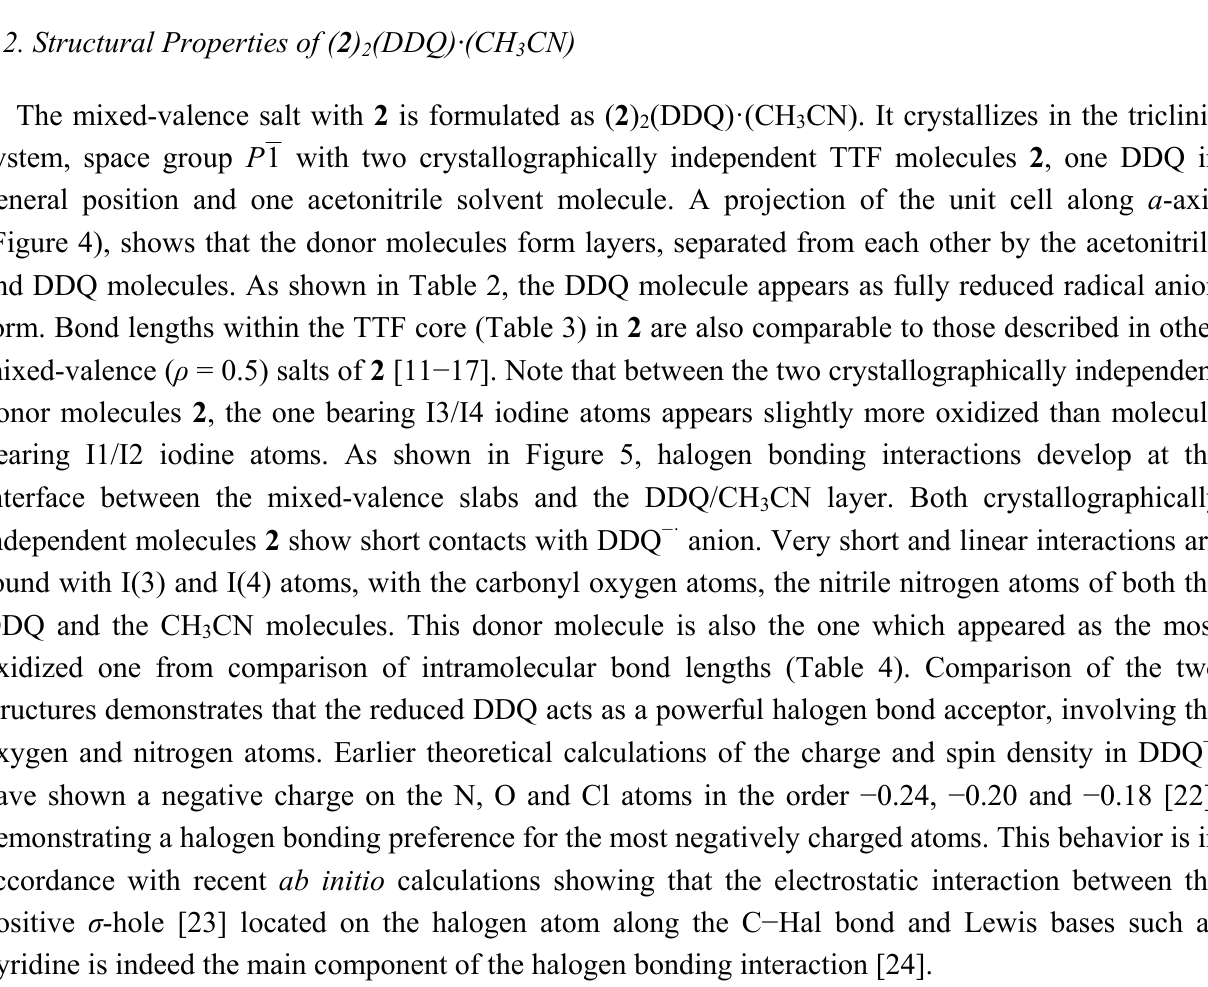
Figure 4. Projection view (along a -axis) of the unit cell of ( 2 )